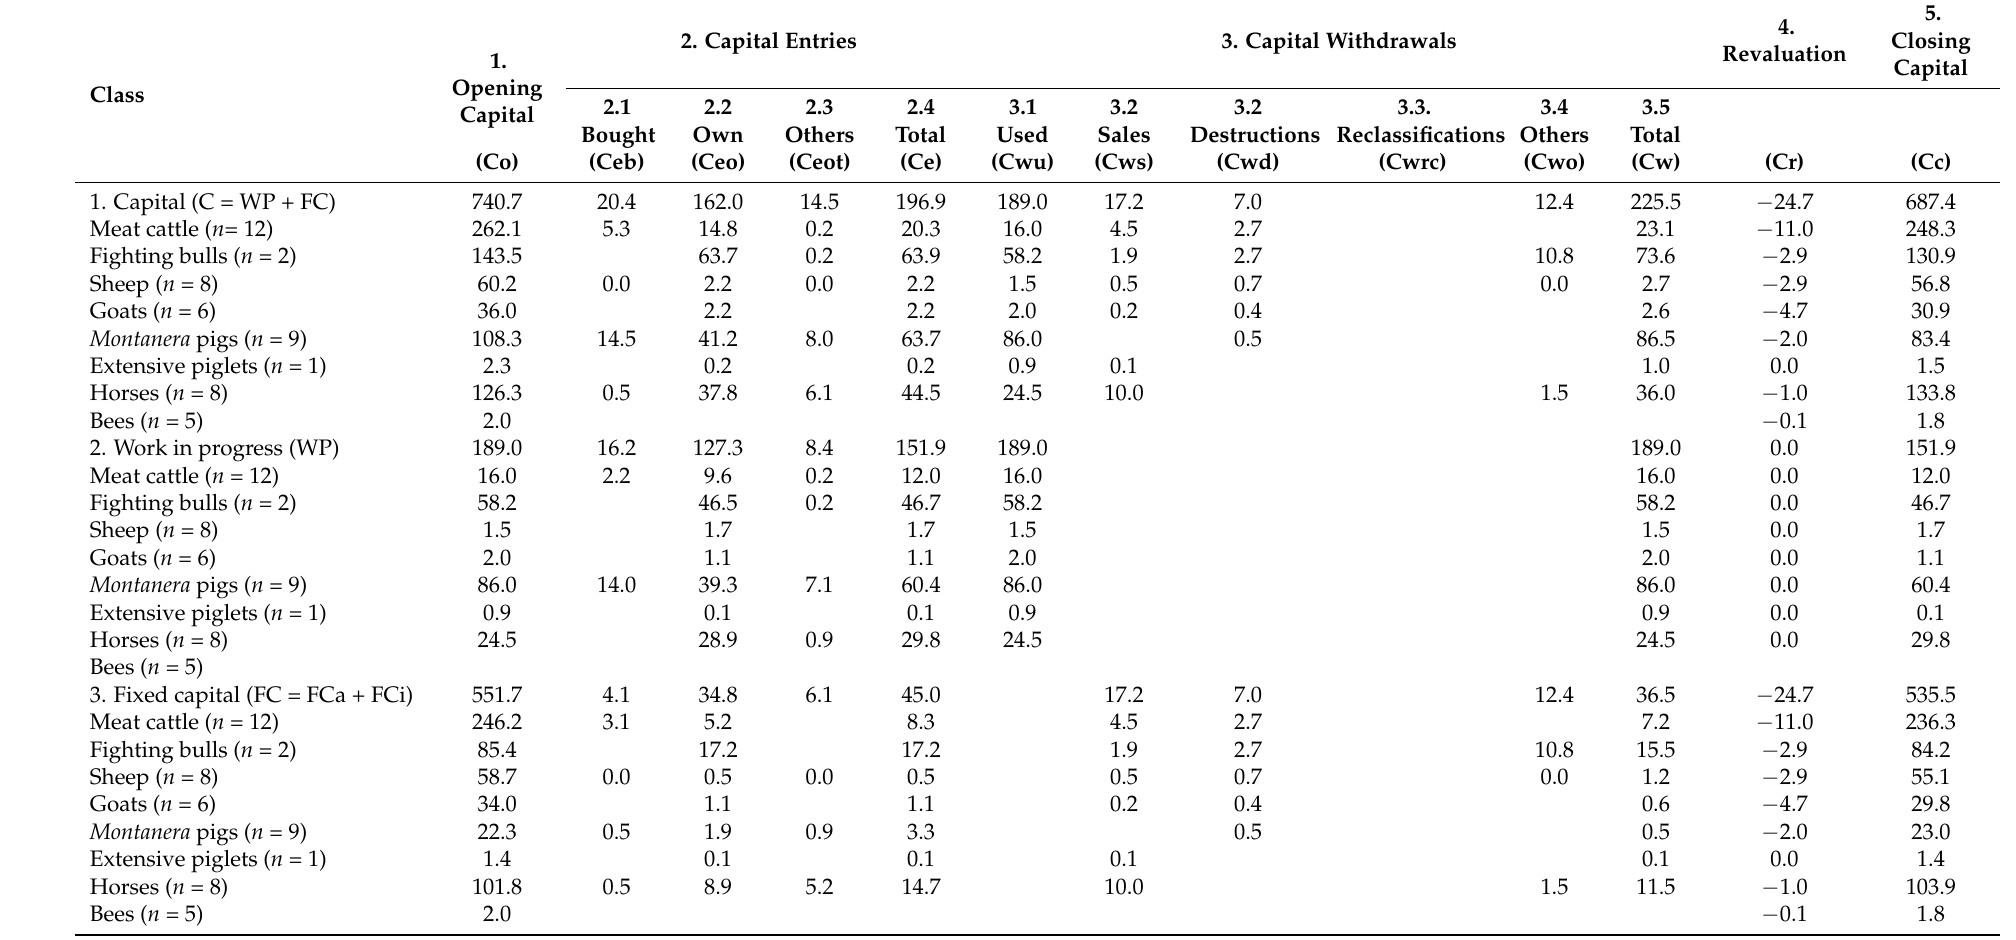
Table A7. Livestock species capital balance under the AAS of large privately owned dehesas in Andalusia (2010: